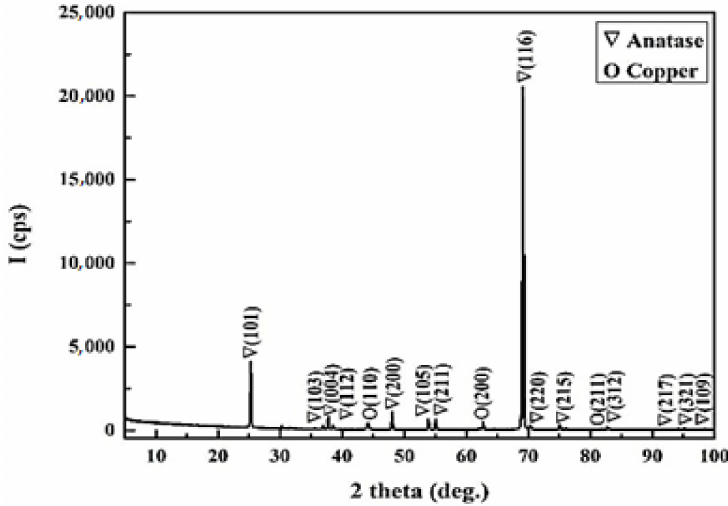
Figure 6. X-ray diffraction (XRD) pattern of TiO 2 doped 2% Cu sample.